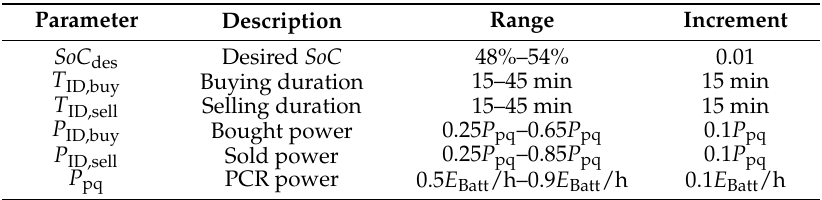
Table 4. Parameter sets for the